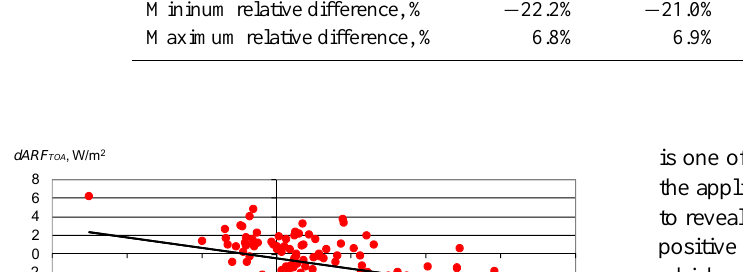
Fig. 9. Single scattering albedo (SSA) as a function of wavelength at different AOT thresholds in Moscow (a) and the SSA difference (dSSA) between Moscow and Zvenigorod (b) .